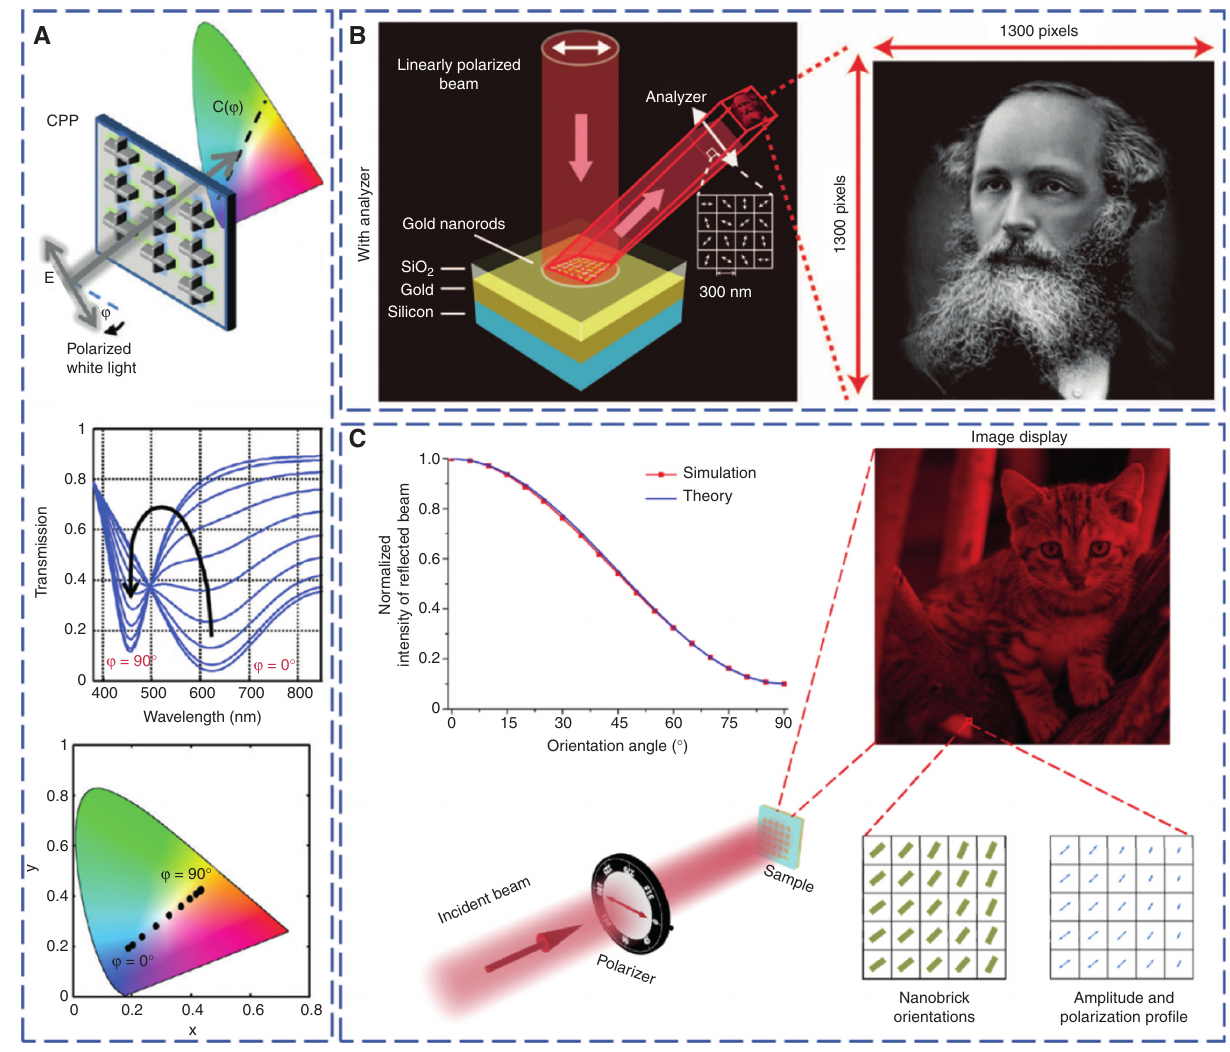
Figure 9: Metaimage displays by intensity control based on Malus’ law. (A) Cross-shaped metallic nanostructures for active color control [79]. (B) MIM nanostructures acting as half-wave plates for intensity manipulation [80]. (C) SOI nanostructures acting as nanopolarizers for intensity manipulation [81]. Reprint permission obtained from